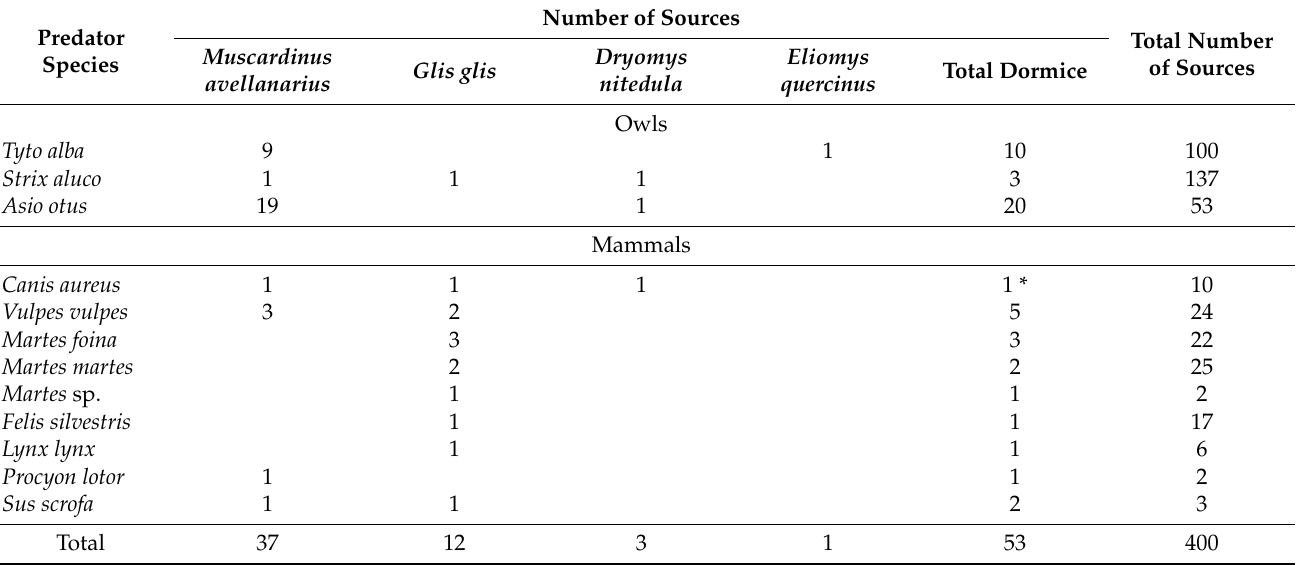
Table 3. Predators in whose diet dormice were recorded in winter period and number of sources containing such